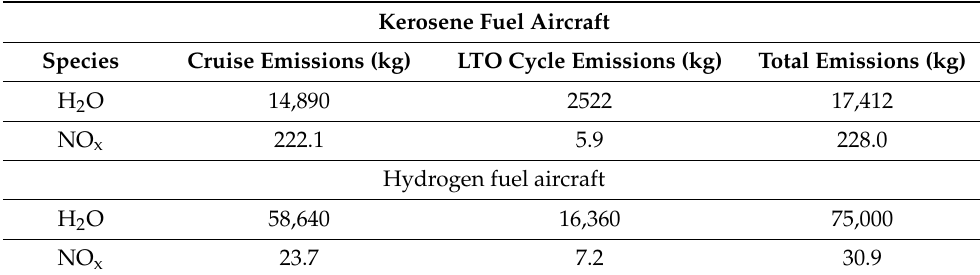
Table 1. Predicted H 2 O and NO x emissions from model kerosene-fuelled and hydrogen-fuelled aircraft. Kerosene Fuel Aircraft Species Cruise Emissions (kg) LTO Cycle Emissions